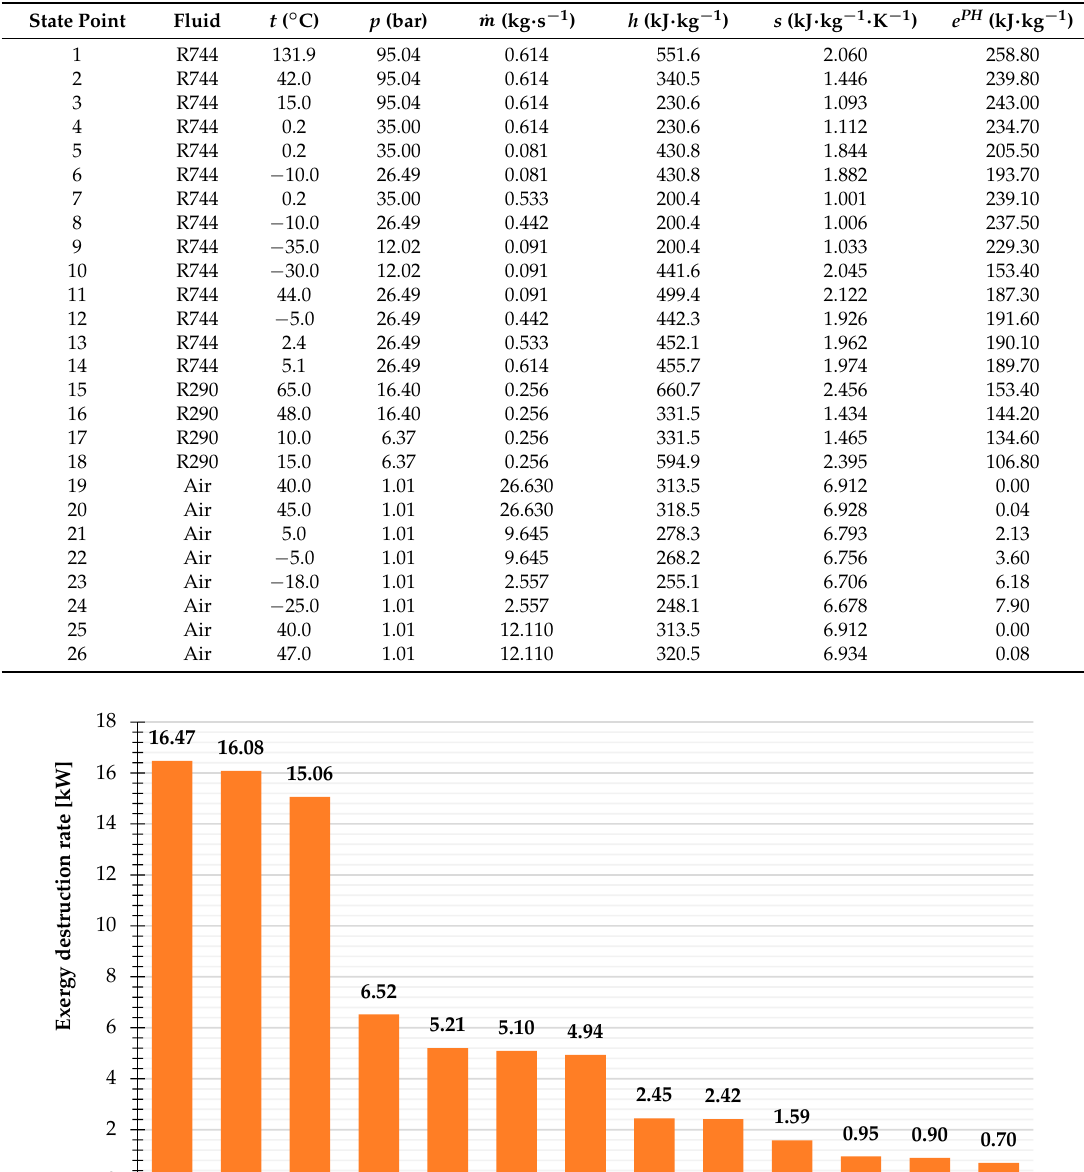
Table 7. Thermodynamic parameters of DMS at the outdoor temperature of 40 °C calculated in real conditions.